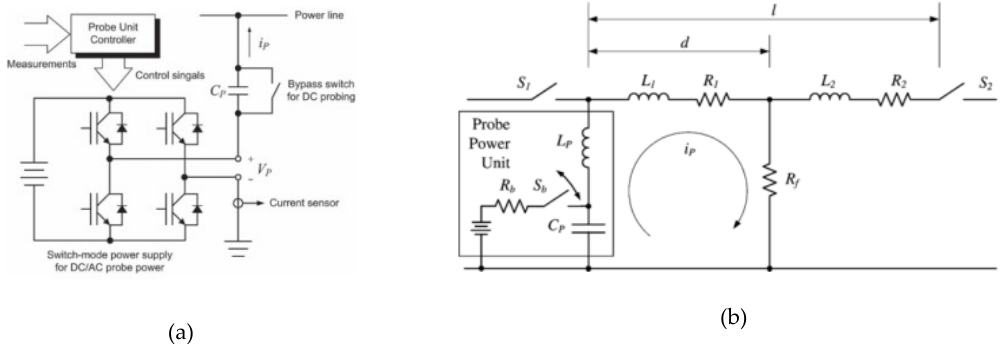
Figure 18. ( a ) Full-bridge Inverter based Probe; and ( b ) Equivalent circuit for probe power unit Figure 18. (a ) Full-bridge Inverter based Probe. ( b ) Equivalent circuit for probe power unit [25].